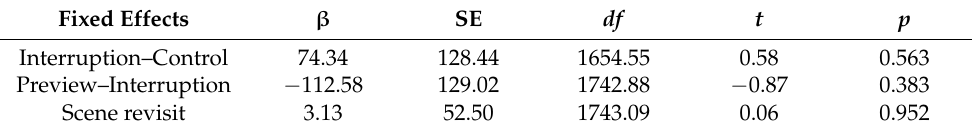
Table A3. Preregistered main analysis of decision time SIE.